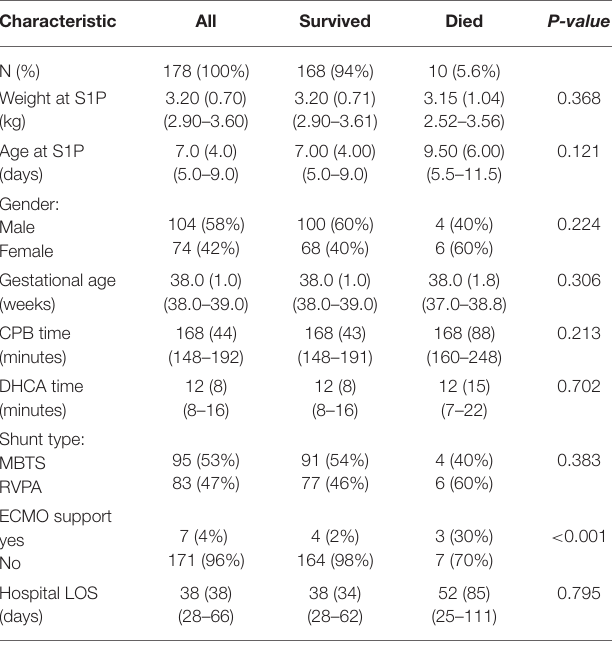
TABLE 2 | Patient population demographics, operative characteristics, and